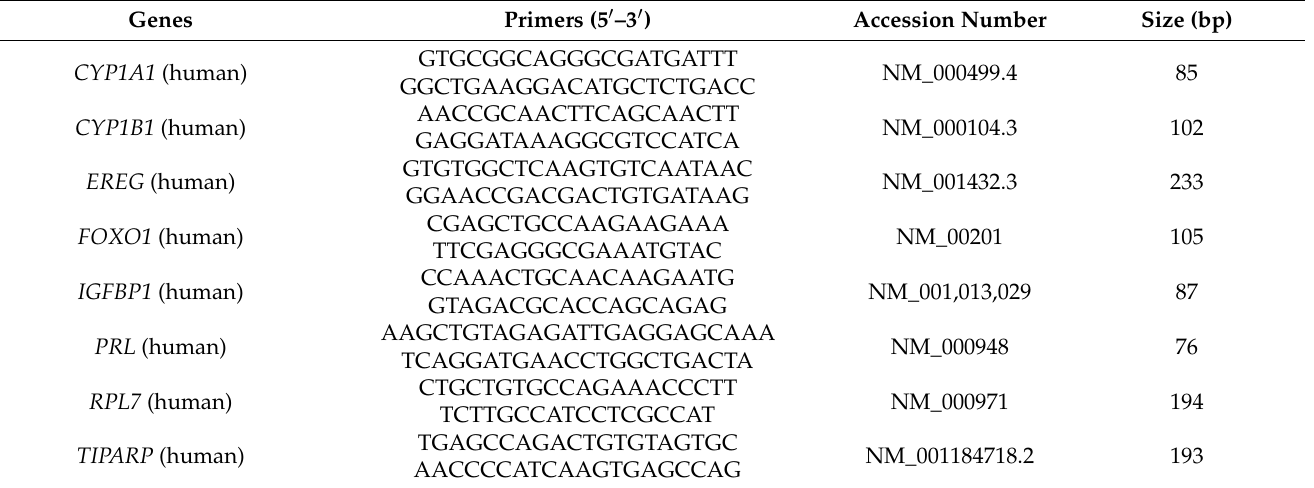
Table 1. Primers for Real-time